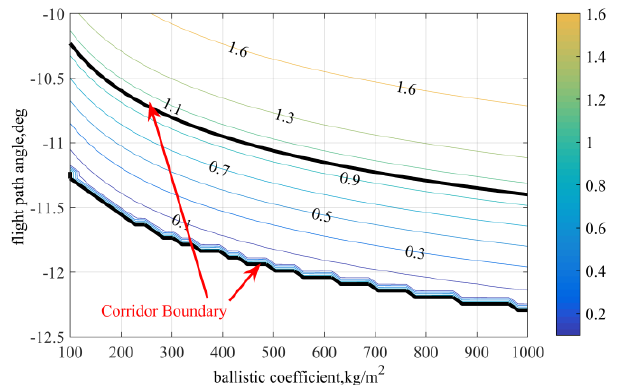
Figure 2. Mars aerocapture corridor in the premise of lift.